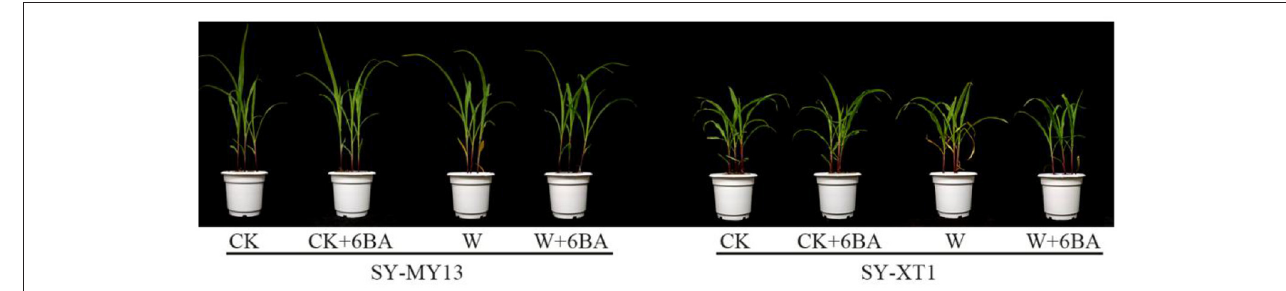
FIGURE 1 | Effects of 6-BA on the phenotype of two inbred lines with different treatments. CK, normal watering conditions only; CK + 6-BA, 0.5mM of 6-BA plus normal watering conditions; W, waterlogged; W + 6-BA, addition of 0.5mM of 6-BA plus waterlogging stress conditions.